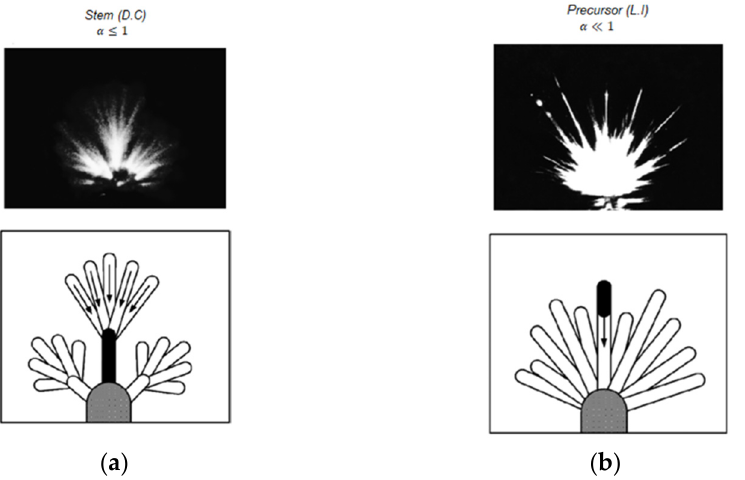
Figure 4. ( a ) Stem mechanism, α = 1, high probability in DC; ( b ) precursor mechanism, α = 0.02, high probability in LI.